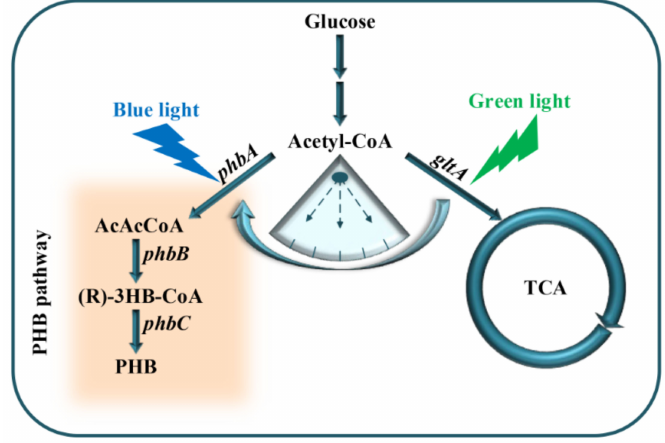
Figure 1. Dynamic regulation of PHB production using an optogenetic dual-switch system; phbCAB , PHB production gene cluster; gltA , citrate synthase used to catalyze acetyl-CoA and oxaloacetate into citrate; green light is used to activate gltA expression using RBS10–CcaS#10–CcaR; phbCAB is activated under blue light using